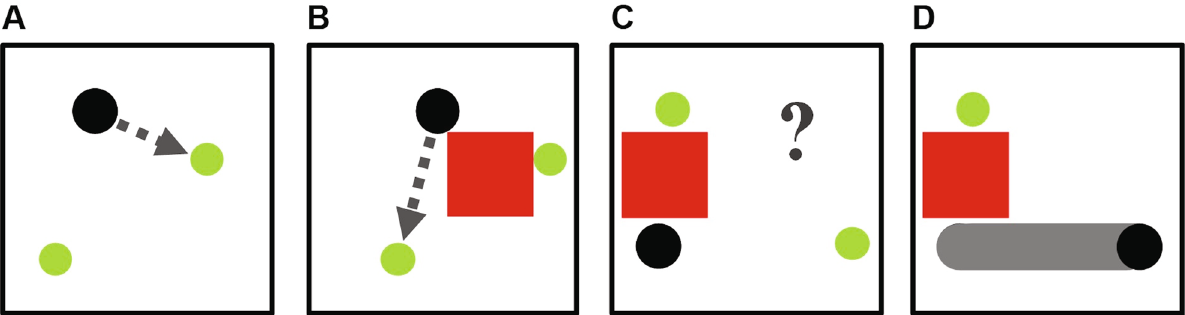
Figure 1. Visual theory of behavior. An actor robot (black circle) is programmed to move towards the nearest food (green circle) that it can see, and consume it. Sometimes ( A ), the nearest green circle is directly visible to the actor, but sometimes ( B ) the nearest green circle is occluded by an obstacle. When occluded, the actor will move towards the closest visible circle, if any. After watching the actor act in various situations, an observer-AI learns to envision what the actor robot will do in a new, unseen situation ( C ). The observer’s prediction is delivered as a visualization of the actor robot’s “trajectory smear” ( D ). This entire reasoning process is done visually, sidestepping the need for symbols, logic, or semantic